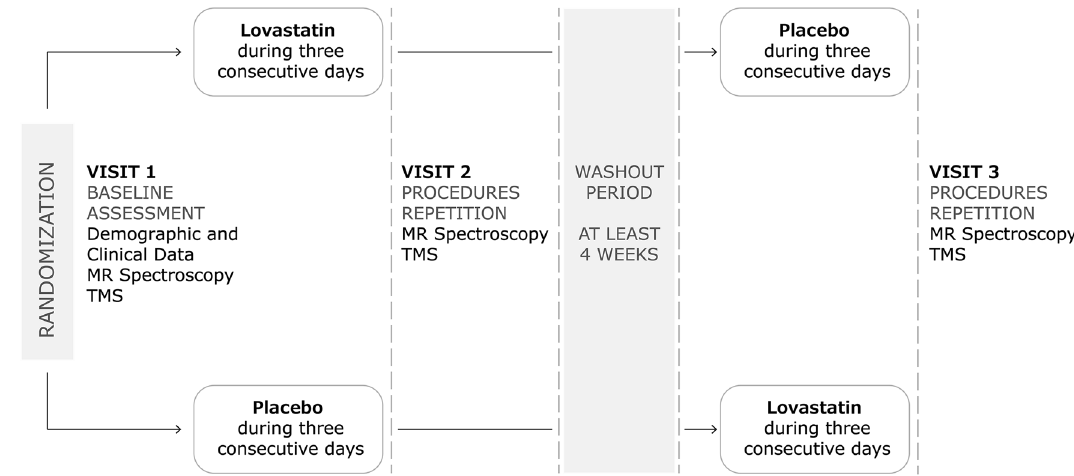
Figure 4. Study design, including the procedures performed in each visit. MR magnetic resonance, TMS transcranial magnetic